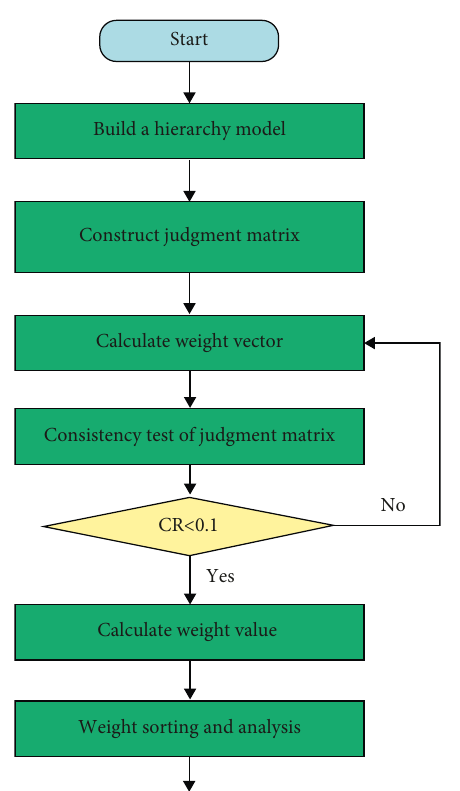
Figure 2: Random consistency index.